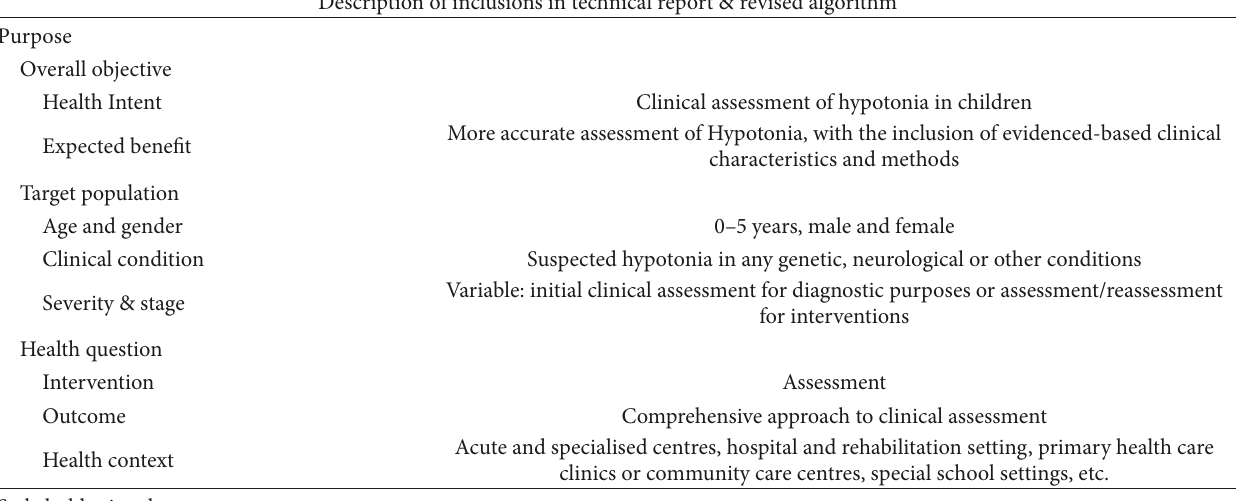
Table 1: Description of changes made to the initial prototype of the